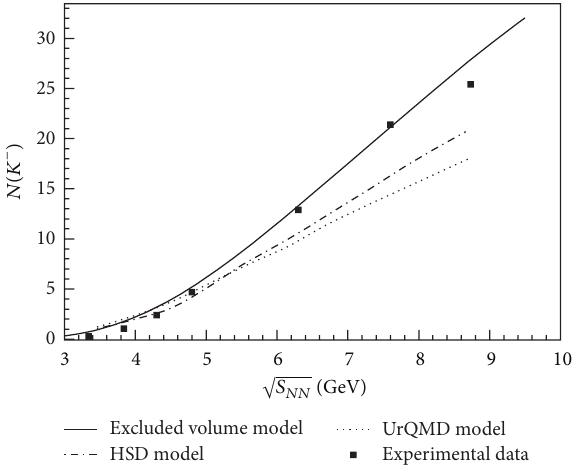
Figure4: Variation oftotalmultiplicity ofproduced 𝐾 − with respect to √ 𝑠 𝑁𝑁 . Dash-dotted and dotted curves are the results obtained from HSD and UrQMD models, respectively [29]. Experimental data is taken from